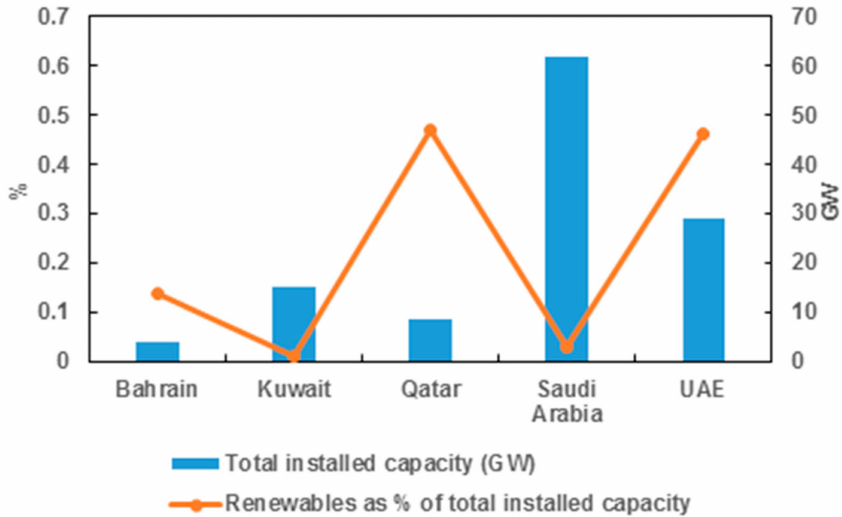
Figure 10. Percentage of RE sources in terms of total installed capacity